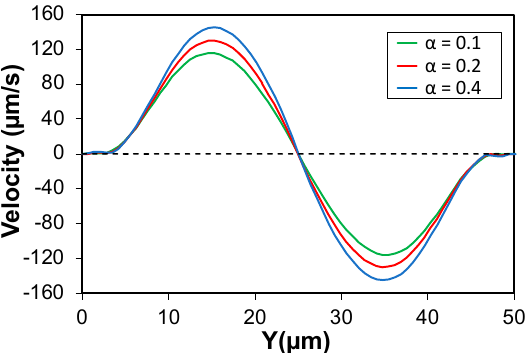
Figure 10. Effect of the mobility factor ( α ) on the magnitude of the N 2 -induced secondary flow. Higher α values increase the magnitude of the secondary flow orthogonal to the main flow direction along the channel horizontal centerline.